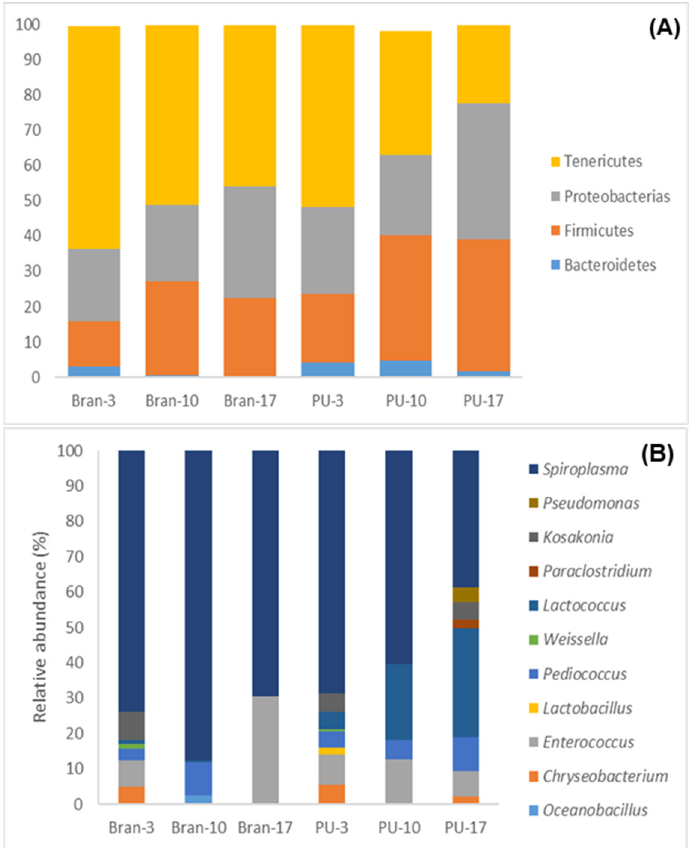
Figure 7. A bar plot of the community analysis of the mealworm gut for the PU diet (PU) and the bran diet (bran) with phylum ( A ) and genus (>1%) ( B ) .